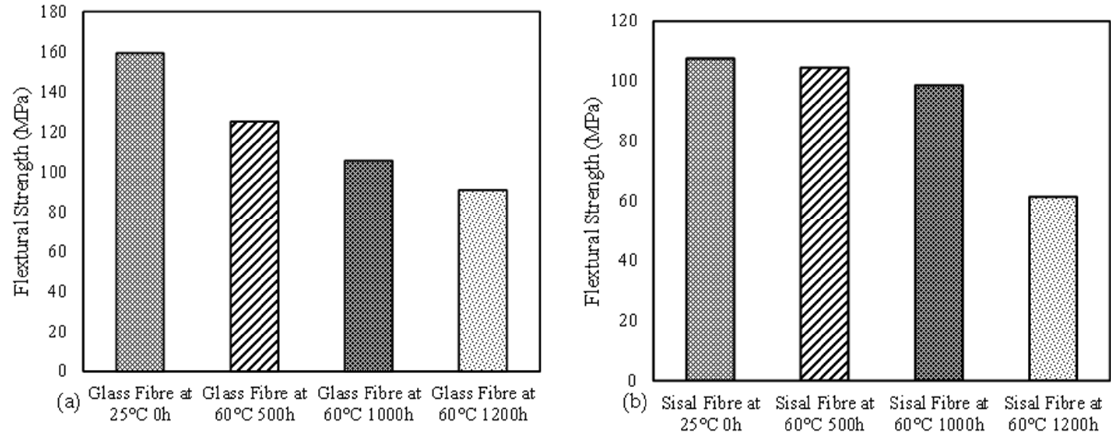
Figure 16. Flexural strengths of GFRE ( a ) and SFRE ( b ) samples under hydrothermal testing.